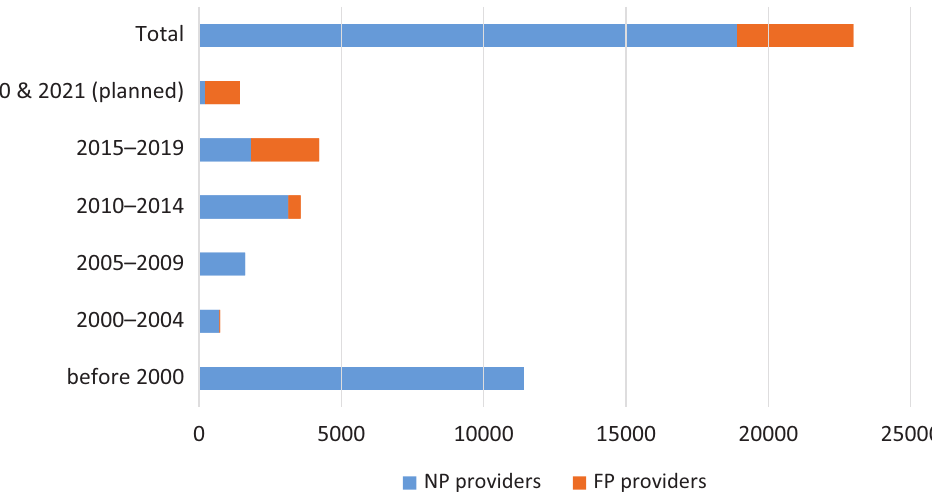
Figure 2. Student housing stock of rooms available in Vienna by provider, categorised by year of opening and in total. Source: Authors’ work based on data collected via desk‐top research, as of February